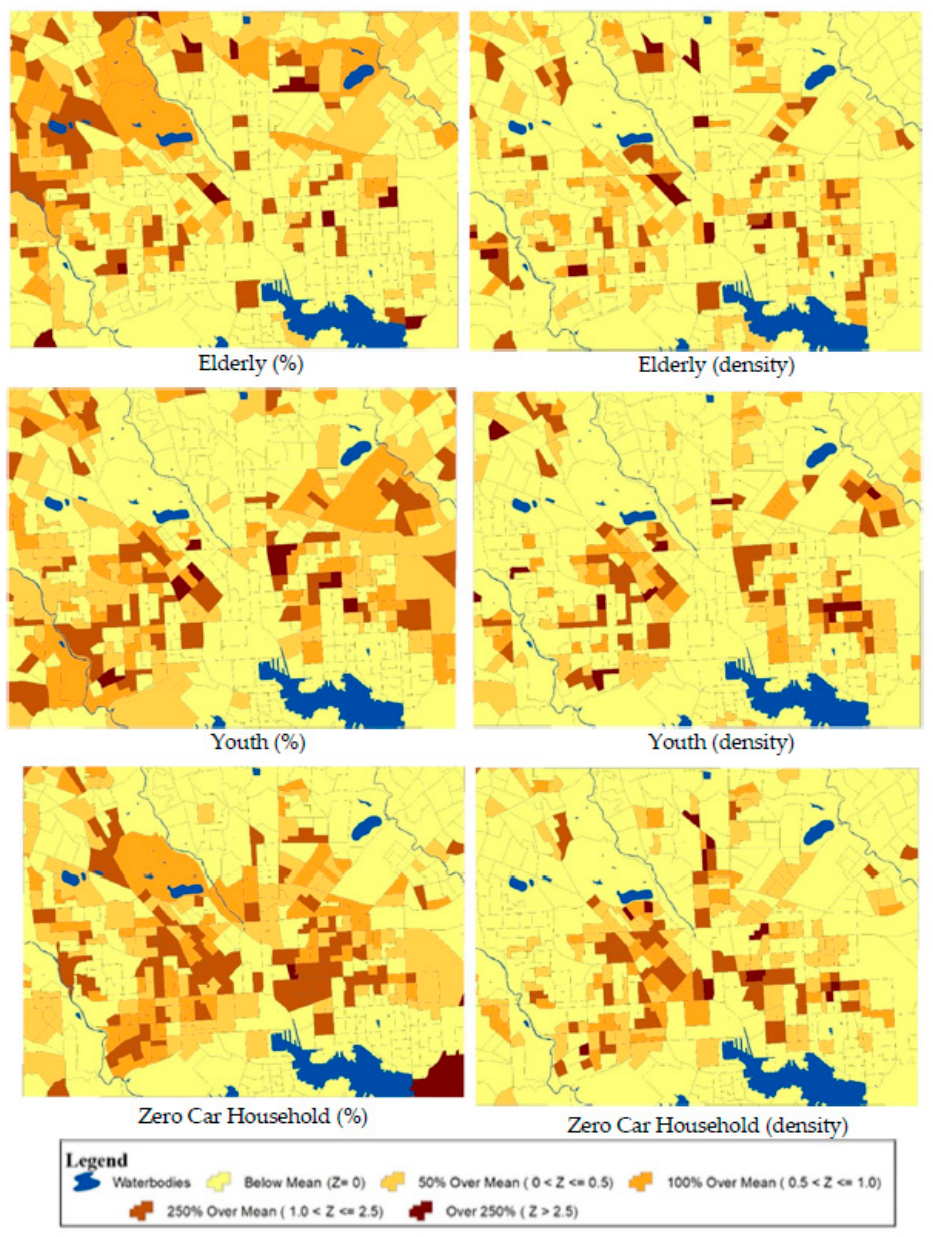
Figure 2. Comparison of Transit Dependent Indicators z-scores.